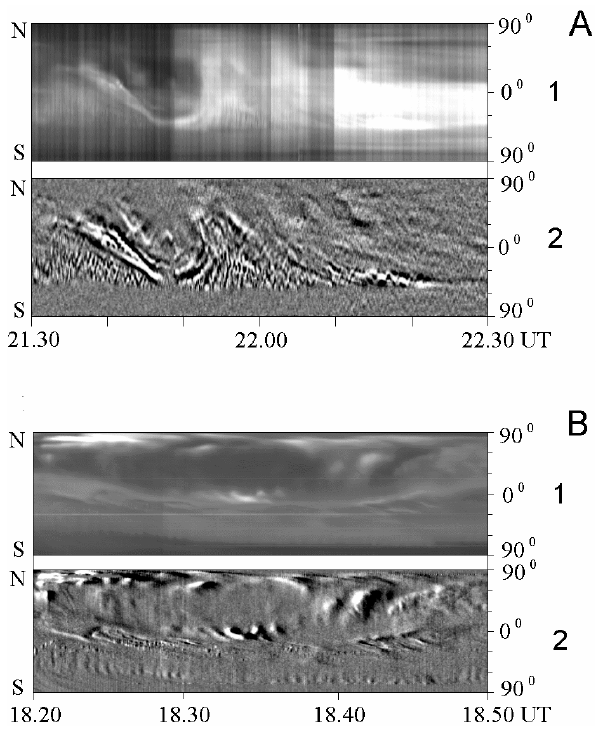
Fig. A1. Using gradient filtering for keogram processing. Suppression of TV camera technical defects and fog. Lovozero, 10 December 1998 (A) . Detection of high-frequency auroral pulsations in the zenith, and low-frequency pulsations at the border of diffuse luminosity. Lovozero, 8 February 1997 (B) . Panels (A1 and B1) are initial keograms, panels (A2 and B2) are gradient filtered